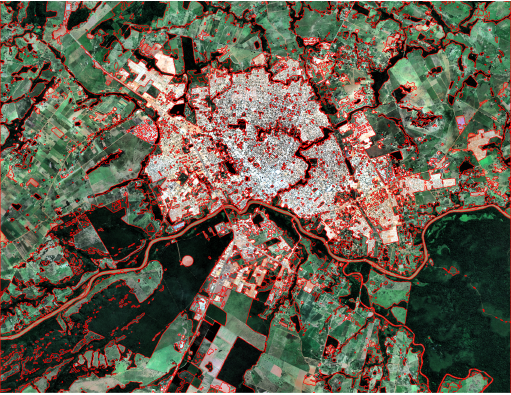
Figure 5. Spatiotemporal segmentation results (red outlines).